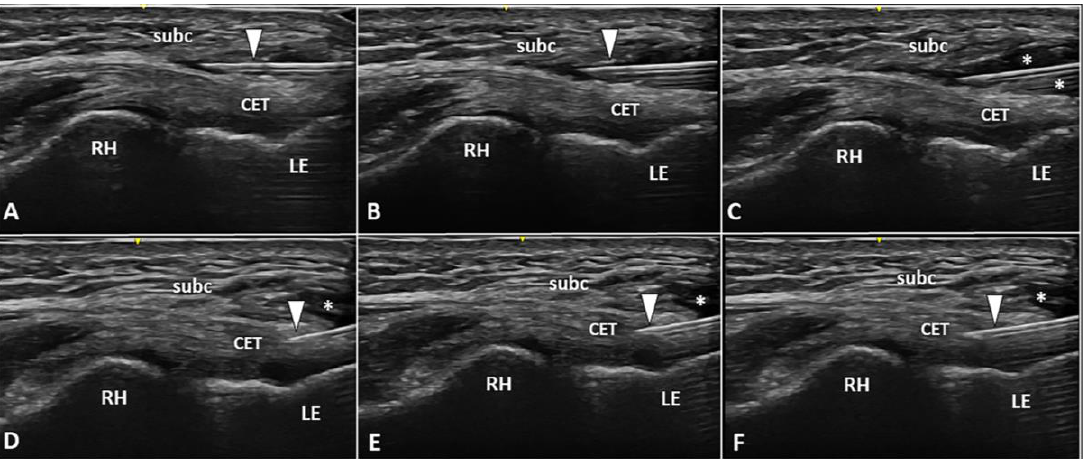
Figure 5. Two-step USG procedure of the lateral elbow using in-plane proximal-to-distal approach. The needle ( white arrowhead ) is advanced in between the subcutaneous tissue ( subc ) and the CET. High volume ( white asterisks ) is injected to efficiently “open” the pathological interface ( A – C ). The needle ( white arrowhead ) is redirected more deeply to perform the fenestration of the pre-insertional segment of CET ( D – F ). RH: radial head, LE: lateral epicondyle.